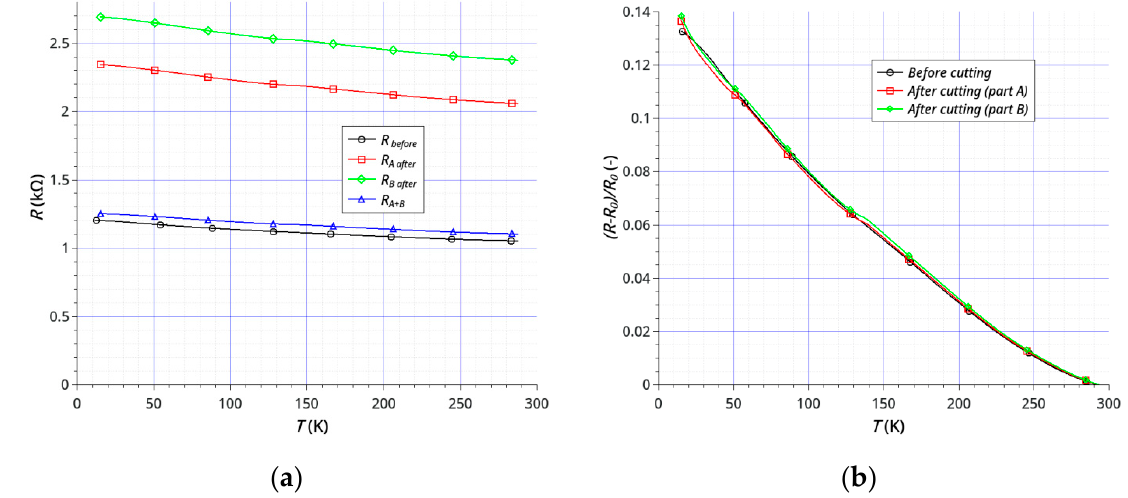
Figure 8 . Temperature dependence of the resistance of the sample before and after laser cutting: ( a ) resistance R (k Ω ) of sample and ( b ) relative change in the sample resistance ( R 0 —initial resistance of the sample at T init = 293 K).